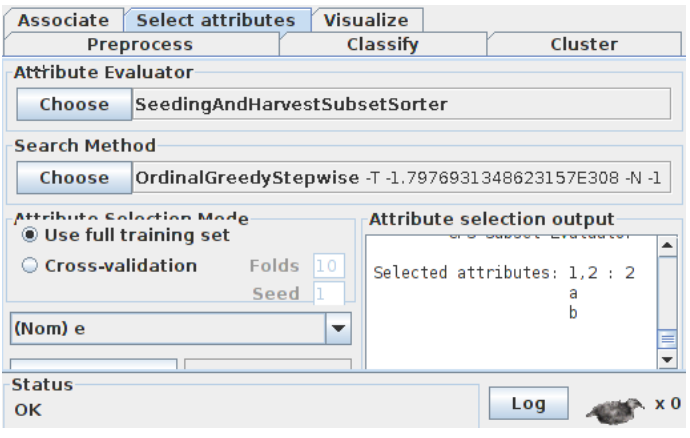
Figure 17. Weka Experimenter using our method.